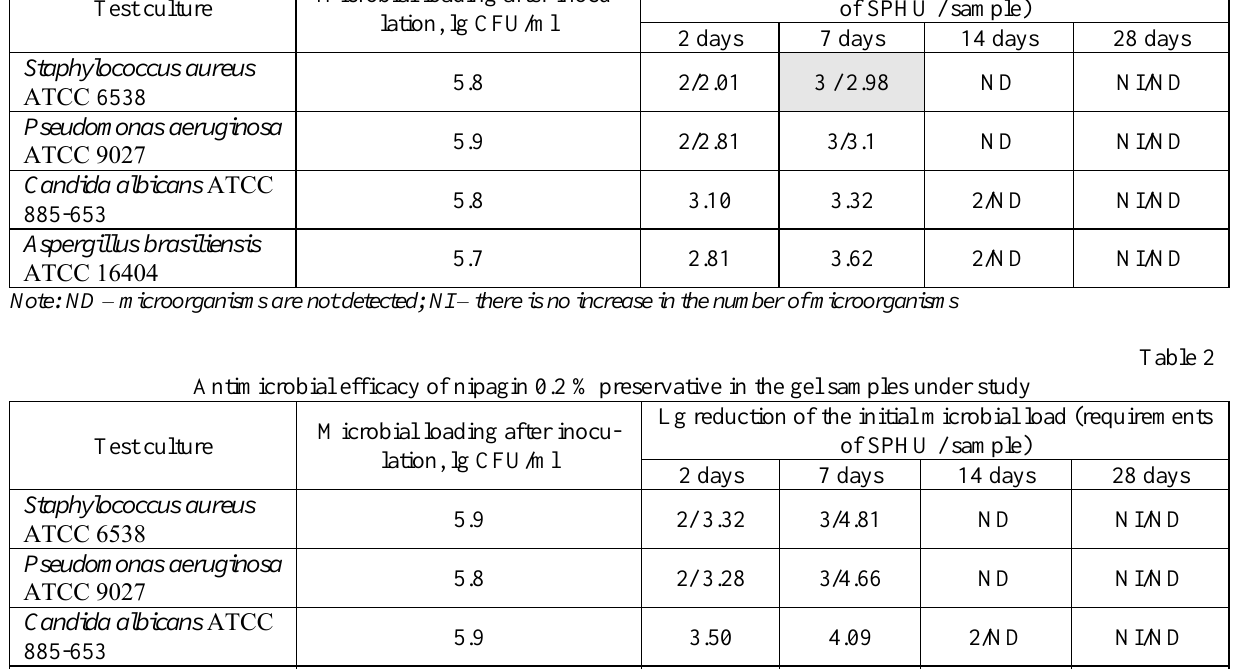
Antimicrobial effect of 0.1 % nipagin preservative in the gel samples under study Test culture